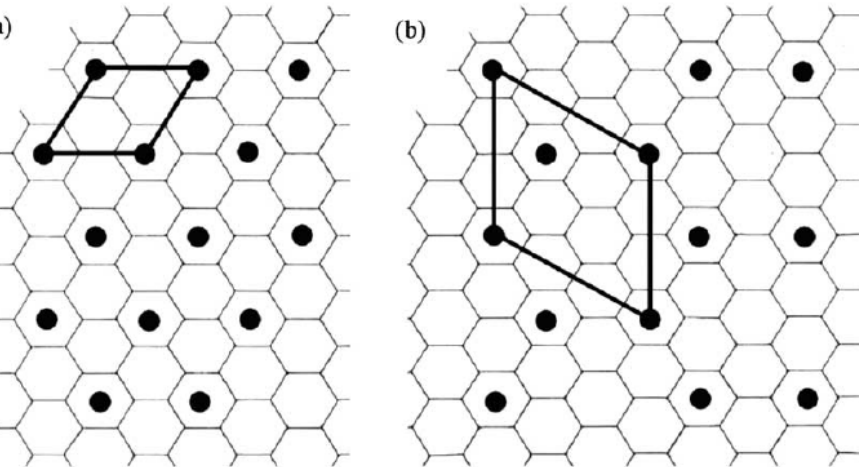
Figure 5. Representations of crystal structures of the lithium intercalation compounds with graphite: ( a ) first stage LiC 6 and ( b ) second stage LiC 18 , projected perpendicular to graphite sheets. The honeycomb network represents an individual graphite sheet and black filled circles the positions of lithium ions. As each carbon atom is a part of three joined hexagons, it follows that each hexagon corresponds to two entire carbon atoms. Therefore, a formula such as LiC 6 implies that there is only one lithium atom per three carbon hexagons. A superdense phase with a formula LiC 2 would have one lithium atom intercalated per each hexagon.